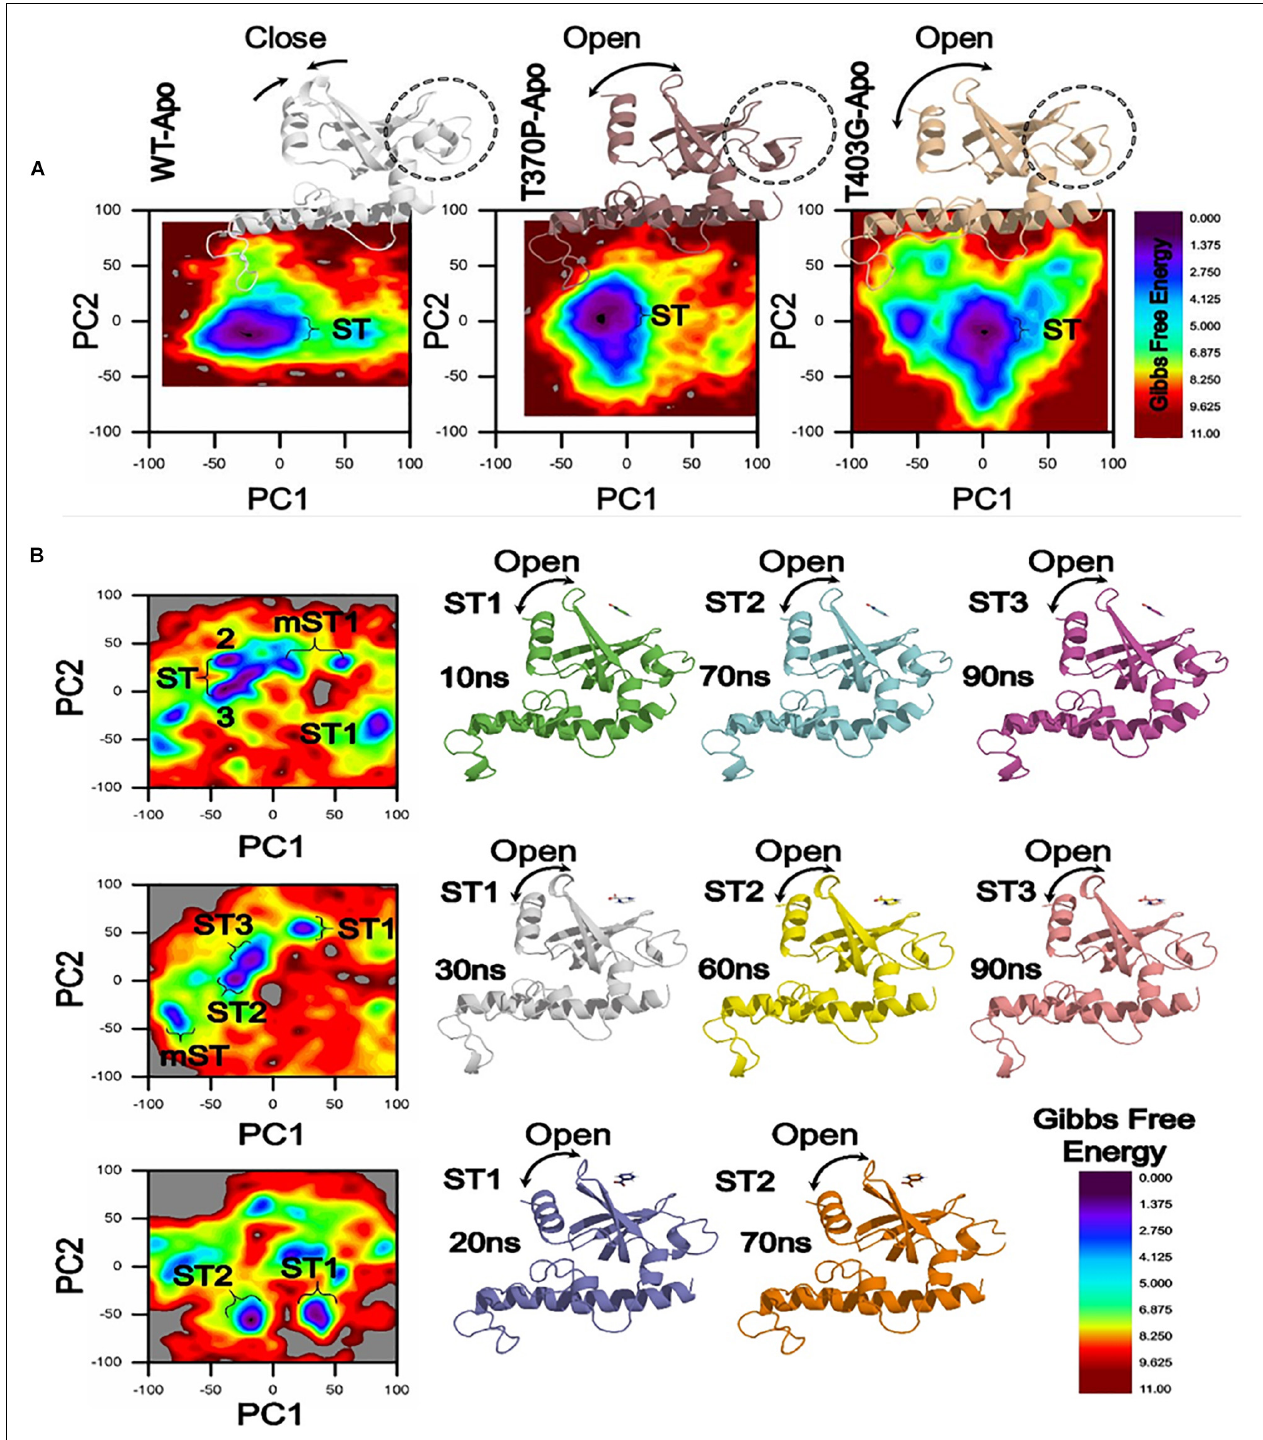
FIGURE 5 | Gibbs Free energy Landscape of WT and MTs (T370P and W403G) in apo (A) and complex states (B) . WT exhibited a GFE difference as indicated by the color of the plot. RpsA structure was analyzed at 10, 20, 30, 60, 70, and 90 ns shows variation among the loop and starting residues in ST1, ST2, ST3. The loop and starting residues of proteins are more open at 90 and 70 ns. ST , stable state; mST , metastable state.